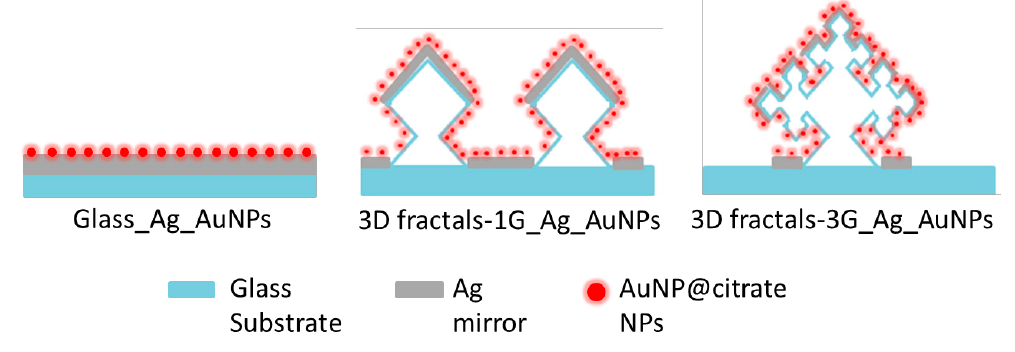
Figure 2. Illustrations of reference ( left side ), 1G fractal ( middle ) and 3G fractal ( right side ) surface-enhanced Raman scattering (SERS) active substrates studied in this work.